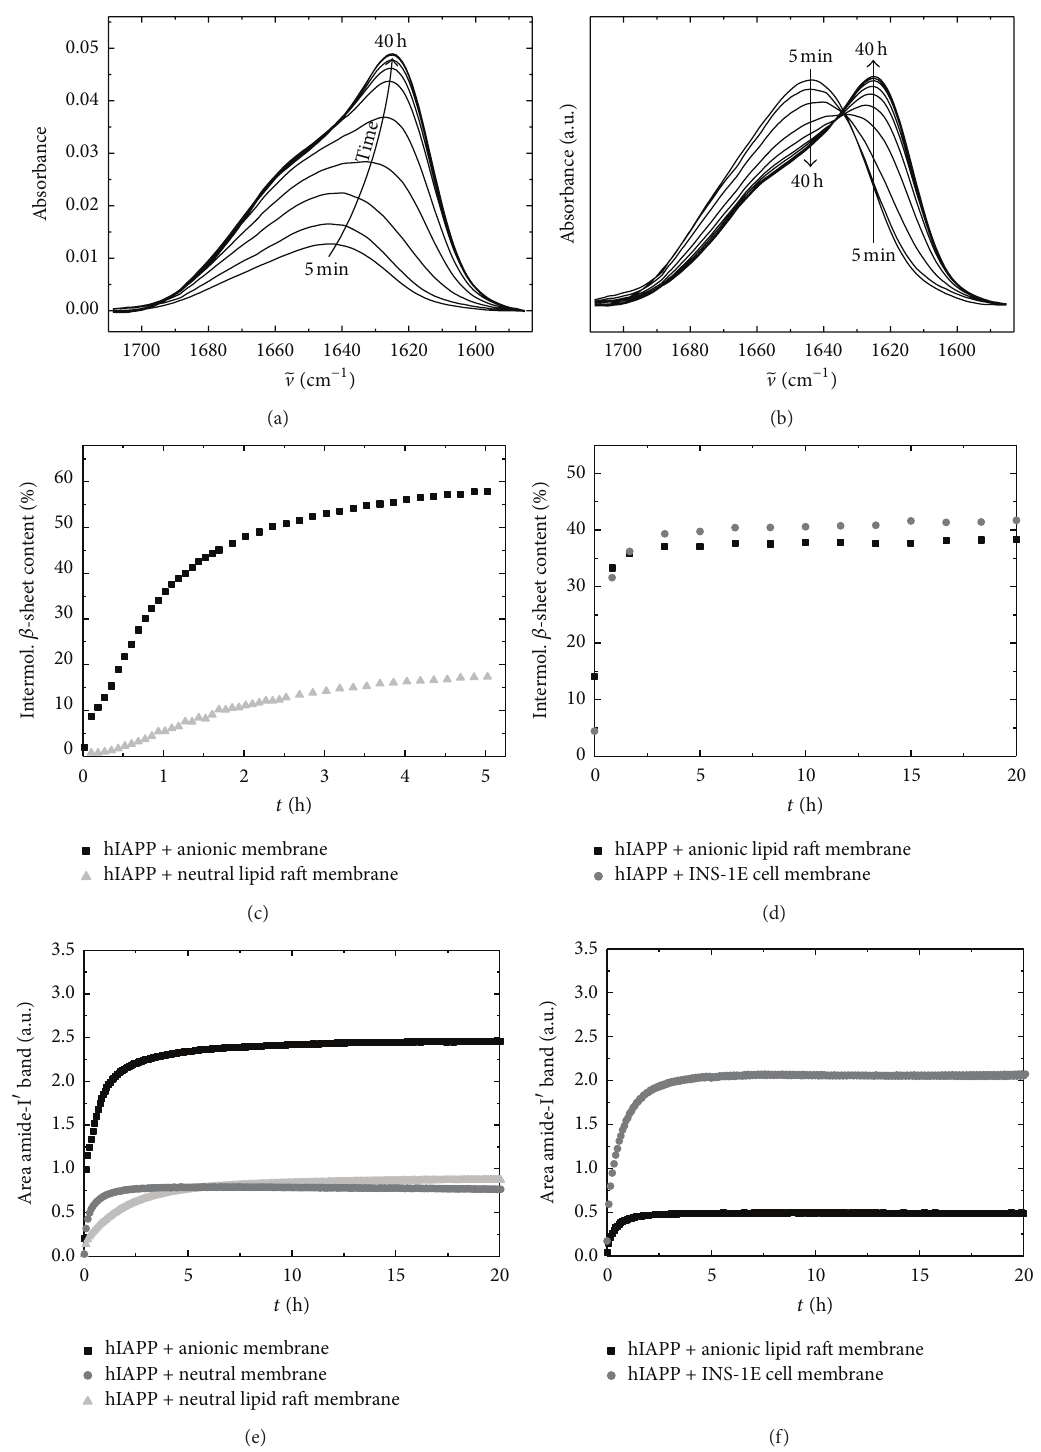
Figure 5: Aggregation kinetics of hIAPP in the presence of different membrane models. Time evolution of the amide-I 󸀠 bands of 3 𝜇 M hIAPP upon aggregation in the presence of a membrane composed of lipids extracted from a pancreatic 𝛽 -cell line of rat (INS-1E) at 25 ∘ C. In (a), primary ATR-FTIR spectra are shown; (b) depicts the concomitant intensity normalized spectra. (c–f) Time evolution of the 𝛽 -sheet content and adsorption kinetics upon aggregation of hIAPP in the presence of various membrane compositions. (c, e) 10 𝜇 M hIAPP at an anionic (DOPC/DOPG, 7 :3, w/w) membrane, a neutral, zwitterionic DOPC membrane and a neutral heterogeneous lipid raft membrane (DOPC/DPPC/chol, 1:2 :1). (d, f) 3 𝜇 M hIAPP in the presence of an anionic heterogeneous lipid raft membrane (DOPC/DOPG/DPPC/DPPG/chol, 15: 10: 40: 10: 25) and a membrane composed of lipids extracted from the pancreatic 𝛽 -cell line of rat INS-1E. Adapted and modified from [56, 60] with permission from